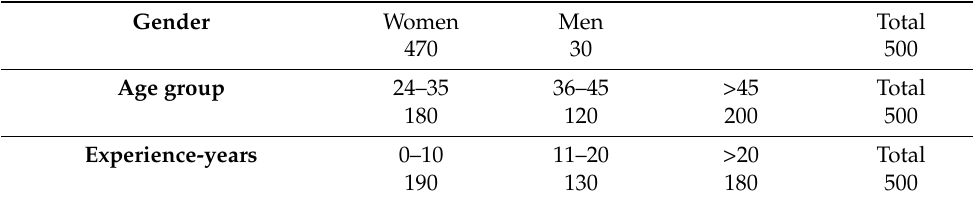
Table 1. Gender, age group distribution, and years of professional experience of the participants in the short survey conducted in public pharmacies in 23 cities in Serbia, from February to April of 2019. Gender Women Men Total 470 30 500 Age group 24–35 36–45 >45 Total 180 120 200 500 Experience-years 0–10 11–20 >20 Total 190 130 180